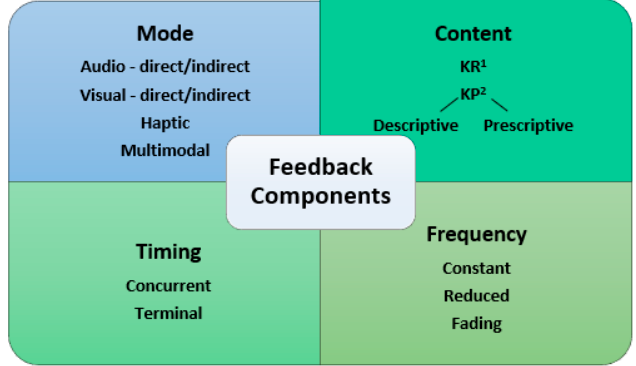
Figure 1. Components of feedback. KR 1 = knowledge of results; KP 2 = knowledge of